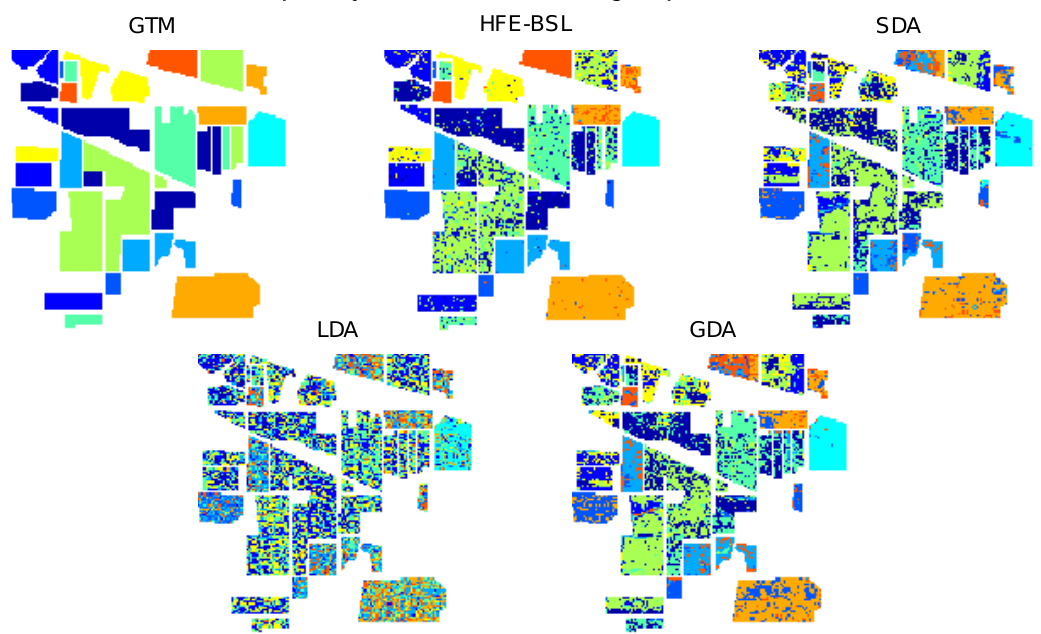
Figure 4. GTM and classification maps for Indian dataset (16 training samples and 9 extracted features are used).